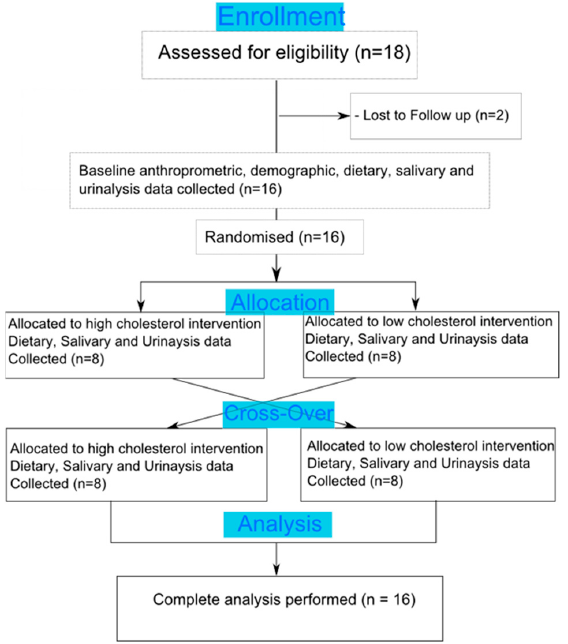
Figure 1. A flow diagram showing the cross-over design of the study.